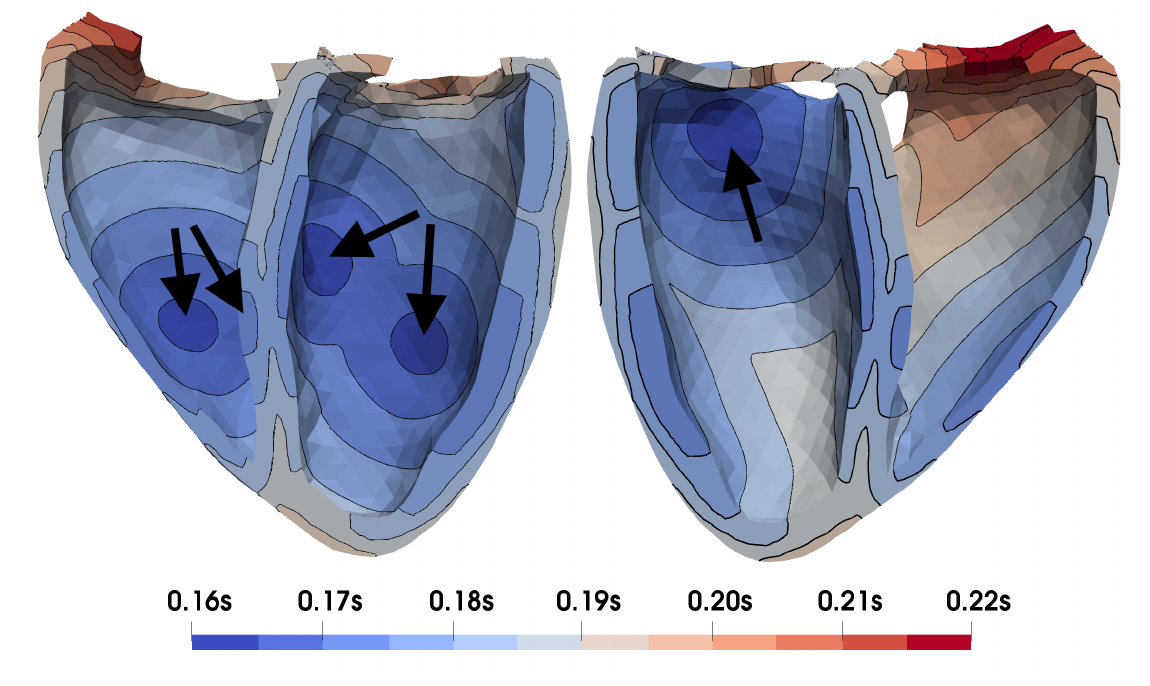
Figure 6. Ventricular local activation times. Arrows indicate sites of earliest activation.